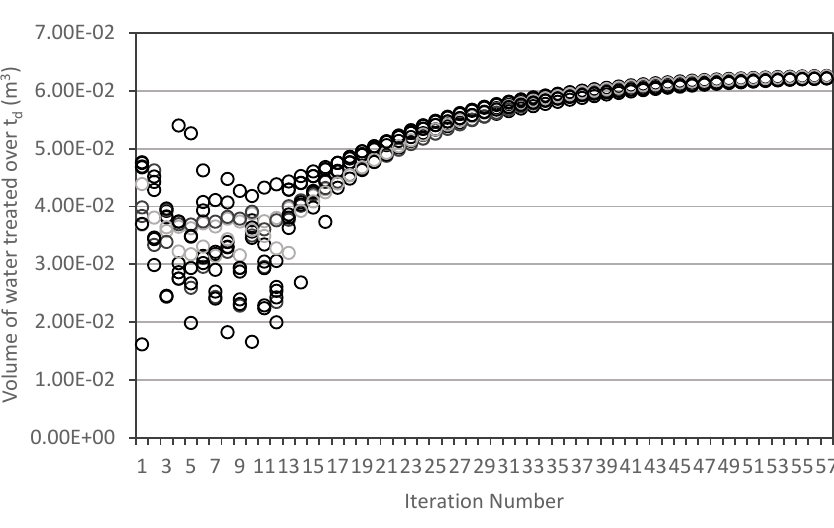
Figure 17. Convergence trend for the treated volume of water within t d period.